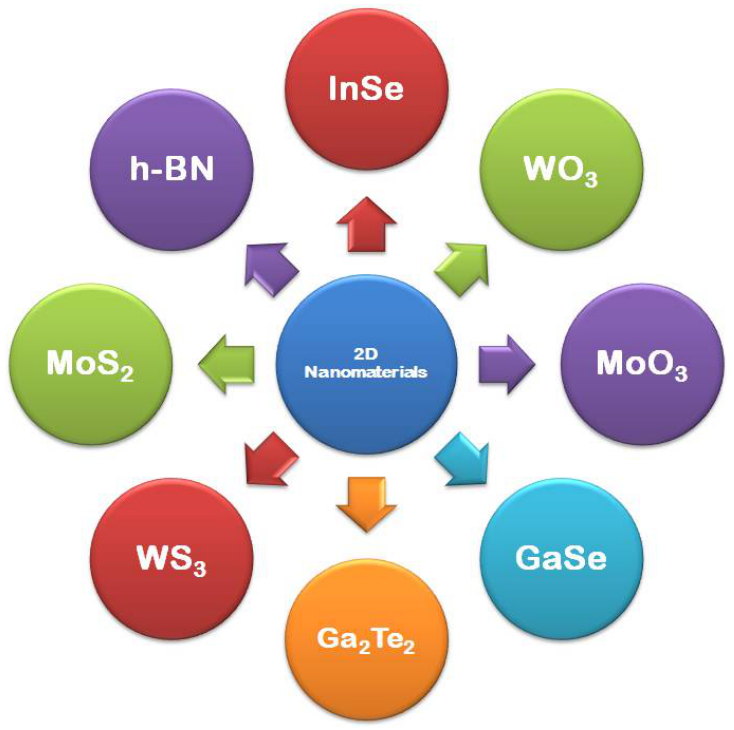
Figure 2. Examples of 2D materials.